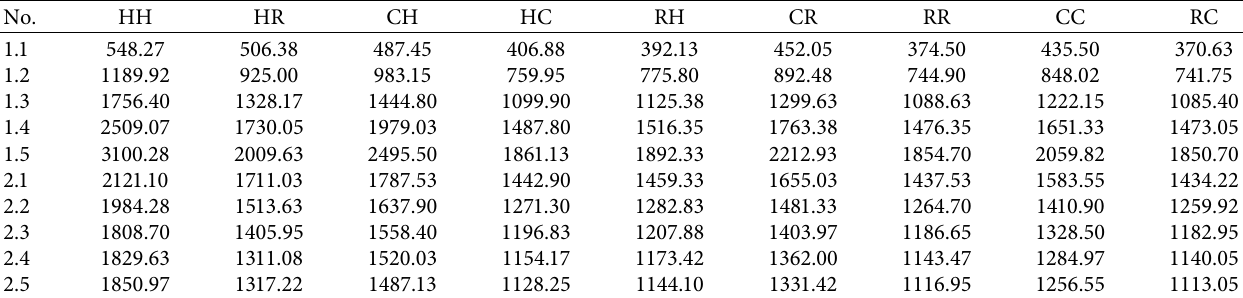
Table 12: Mean lengths of schedules returned by the LS algorithms for the benchmark given in [9] with cov � 100%. No.